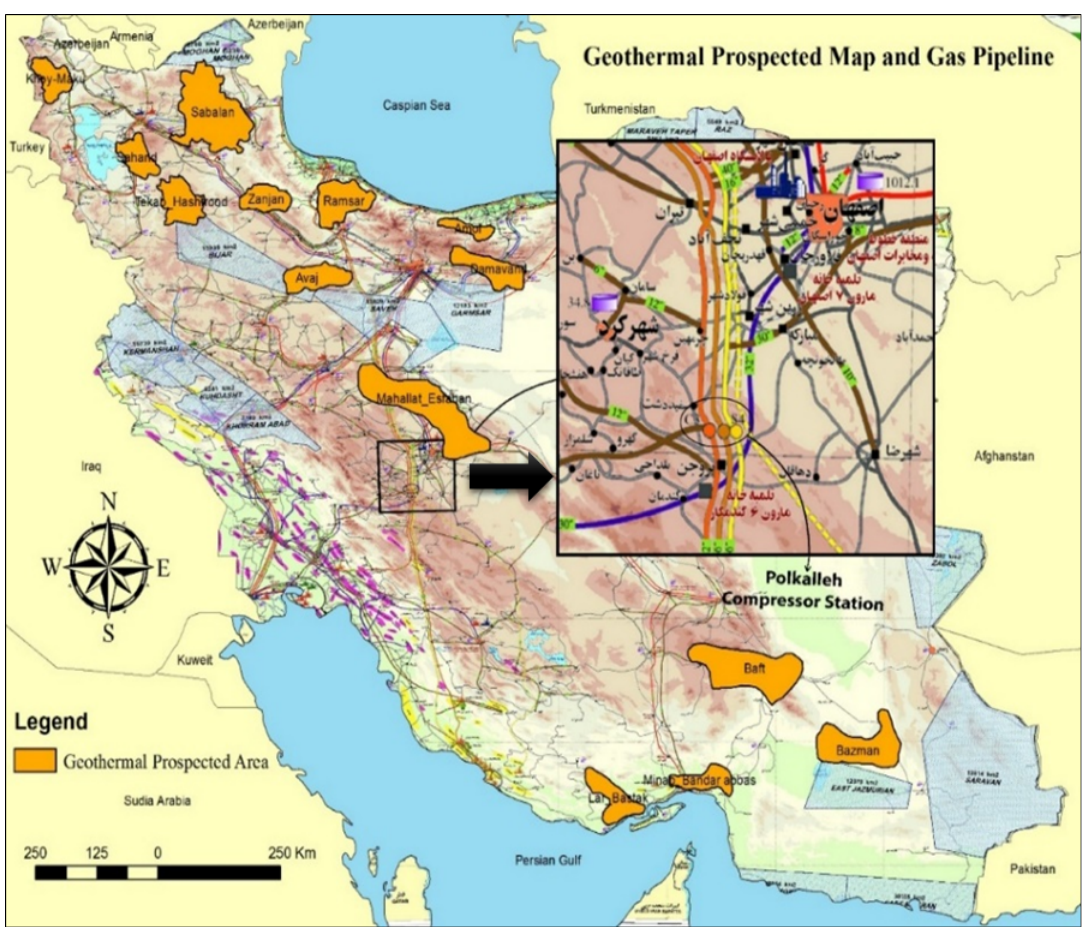
Figure 1. Polkalleh CS location on the general map of the petroleum industry of Iran (Courtesy of Iran National Cartography Center) and Iran Geothermal prospected map (Noorollahi et al.